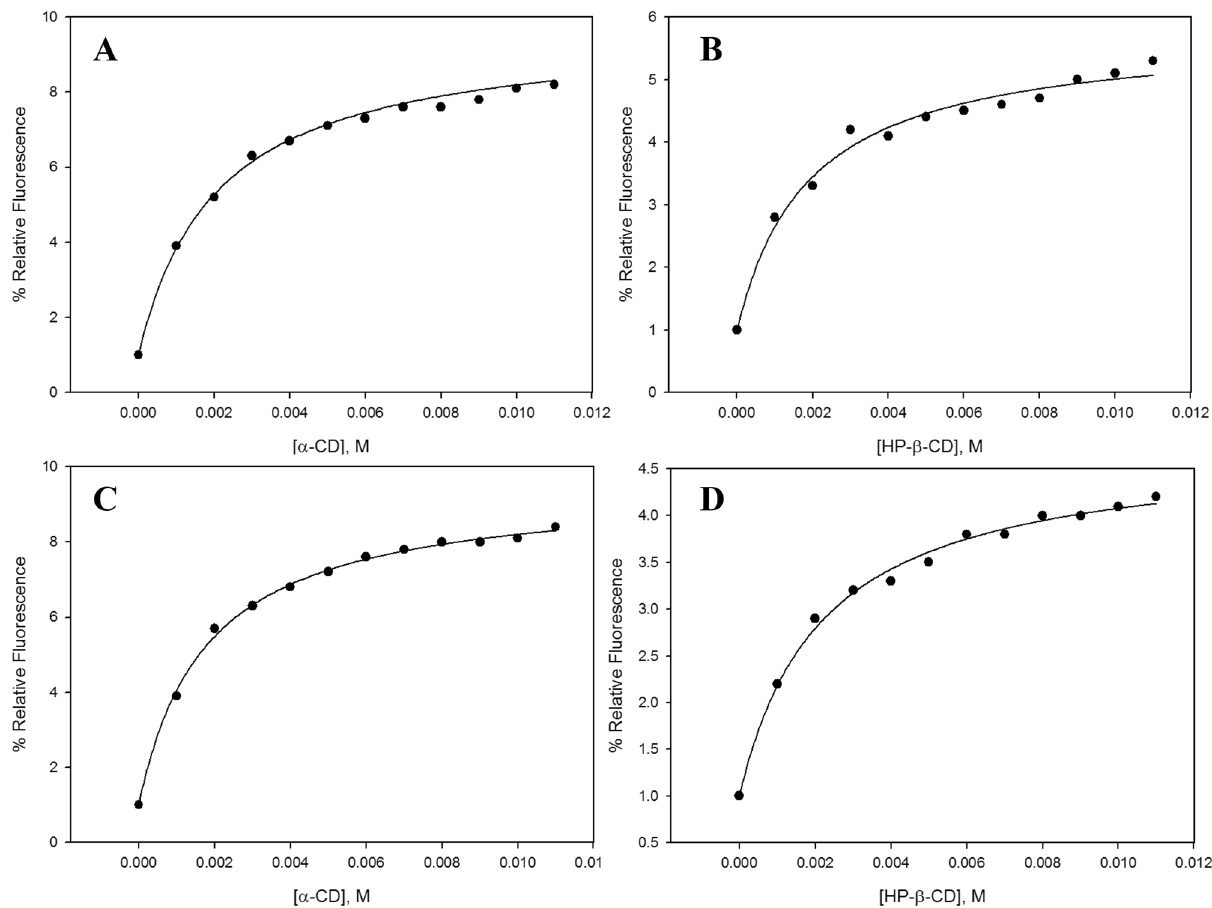
Figure 3. Plotting data, fitted with Eq. (3), of the relative fluorescence signal of neochlorogenic acid vs. ( A ) α-CD and ( B ) HP-β-CD concentration, and the relative fluorescence signal of chlorogenic acid vs. ( C ) α-CD and ( D ) HP-β-CD concentration (25 °C pH